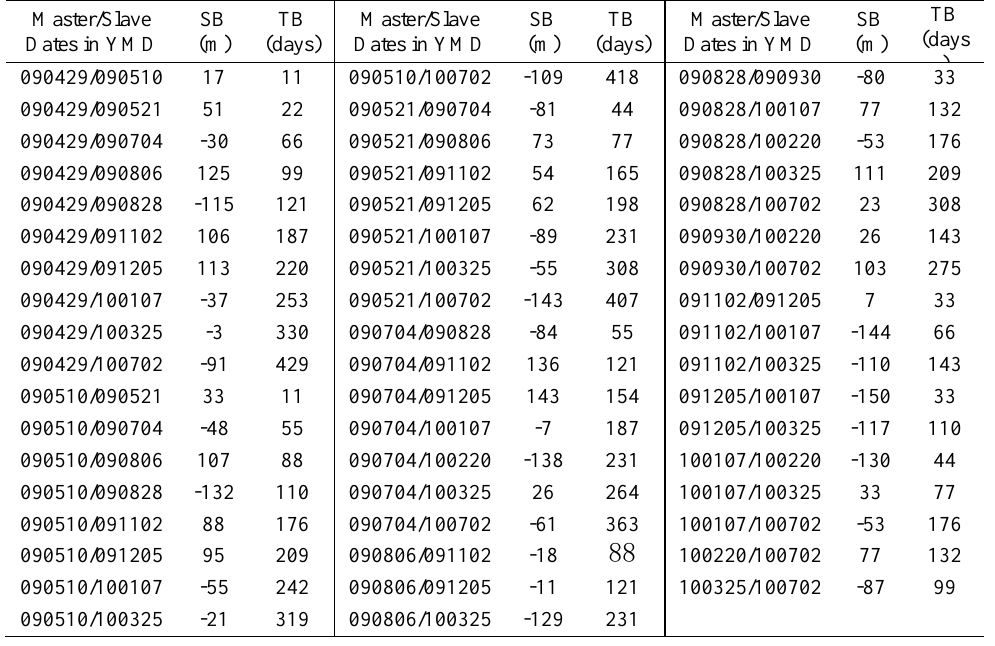
Table 1 53 short baseline interferograms